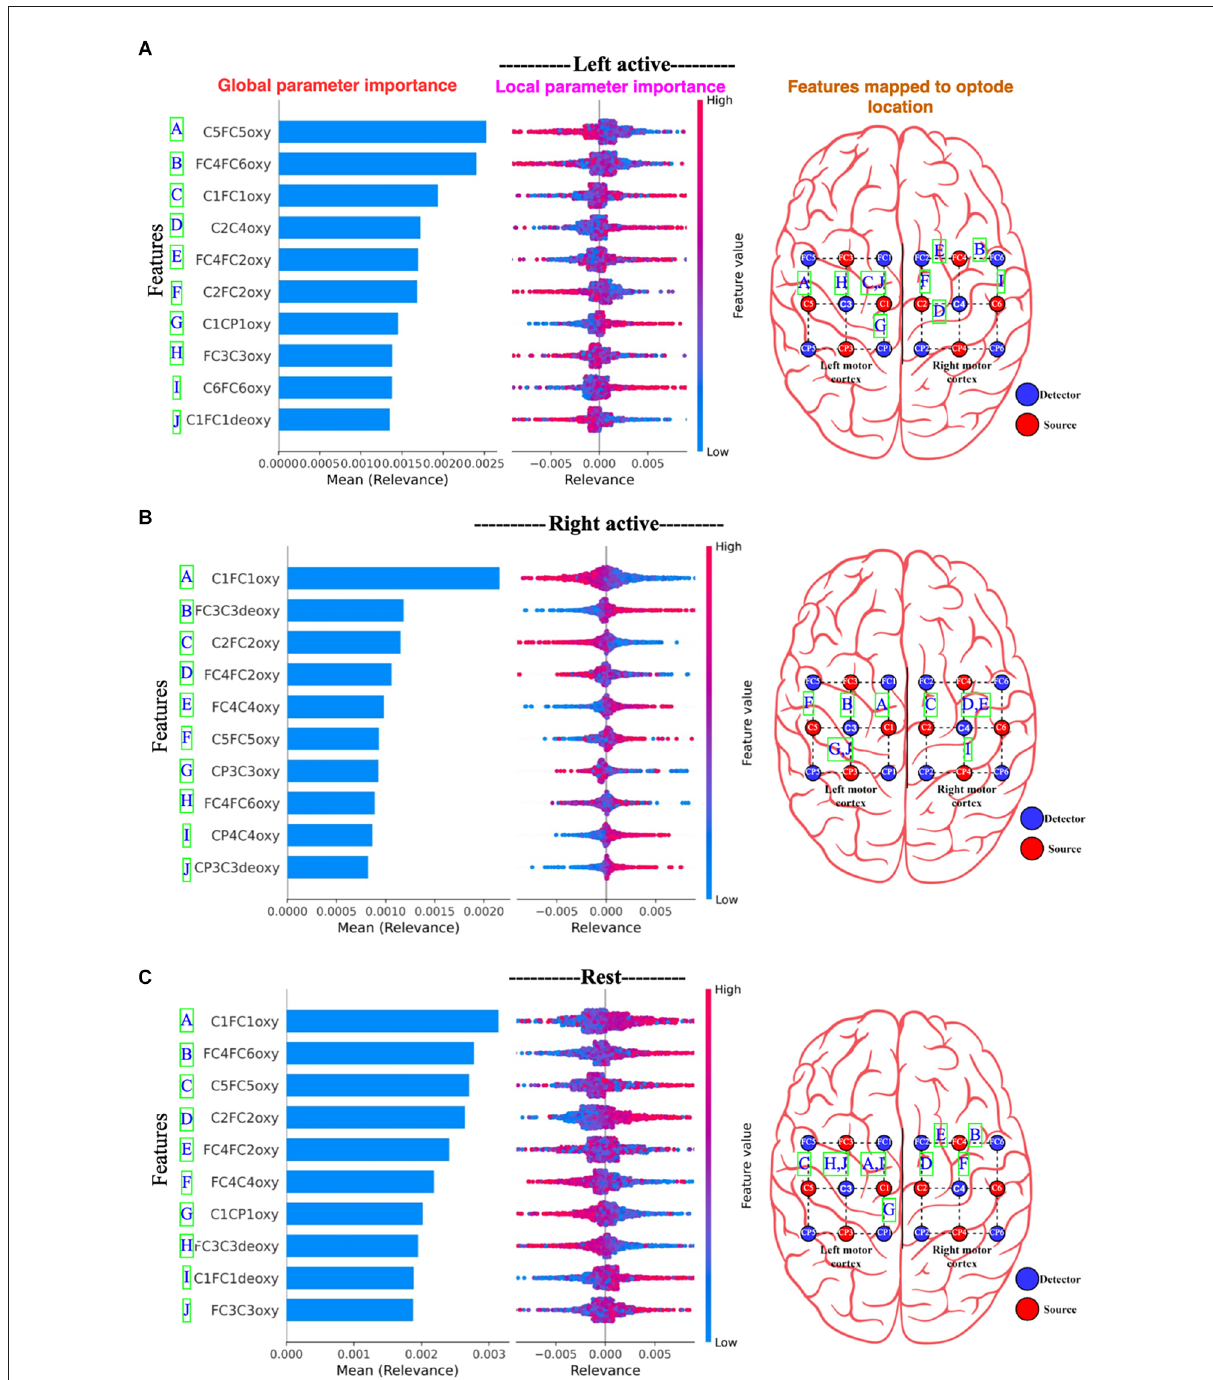
FIGURE15 Panel (A) representsLeftactivemotortask; (B) representsRightactivemotortaskandlikewise, (C) representsRest.Theglobalfeatures’importance and local explanations summary are displayed in the results of the explanation module for Dataset A. Note only 10 channels are plotted. On the right most part, the channels are mapped to the edges of the optode locations.